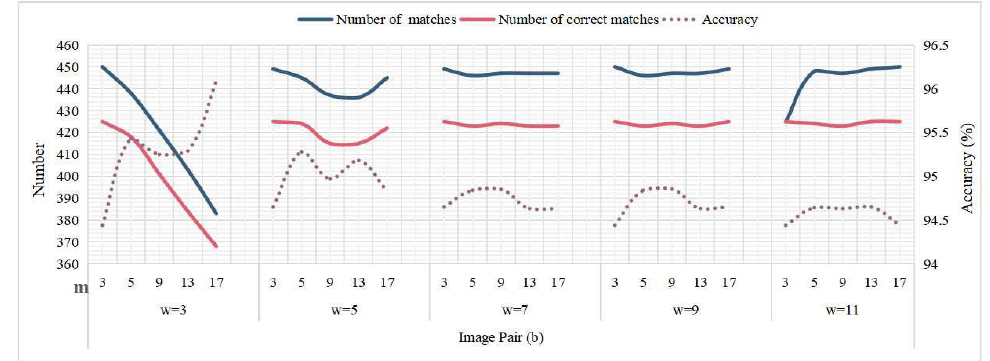
Figure 10. Performance of our approach with different m and w for Figure 7b image pair.